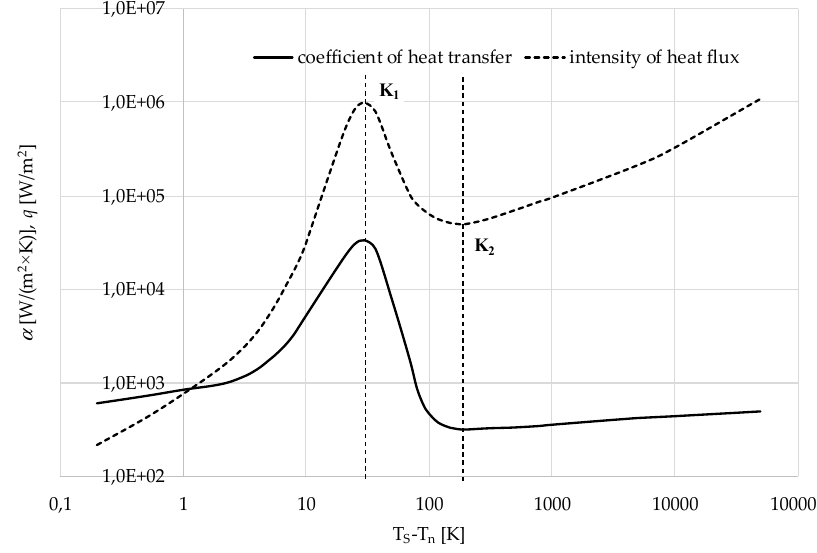
Figure 6. Relationships between the heat flux density q and the heat transfer coefficient α and the difference between the hot surface/saturation temperatures (T S -T n ) [19,24,25]. Legend: K 1 –critical heat flux, K 2 –Leidenfrost point.